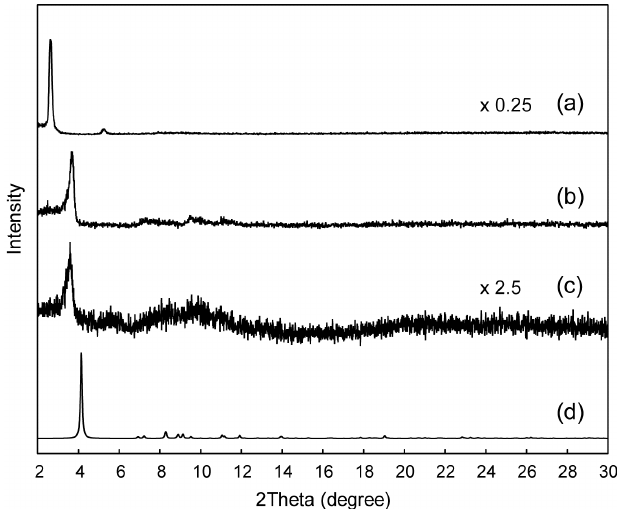
Figure 3. Powder X-ray diffraction patterns of C 12 pda-V 10 hybrids: ( a ) dark green C 12 pda-V 10 hybrids synthesized at pH 6.0; ( b ) yellow C 12 pda-V 10 hybrids synthesized at pH 4.0; ( c ) C 12 pda-V 10 crystals obtained from the filtrate of the synthesis at pH 6.0; ( d ) Calculated pattern of C 12 pda-V 10 crystals using the structure obtained by single-crystal X-ray diffraction.